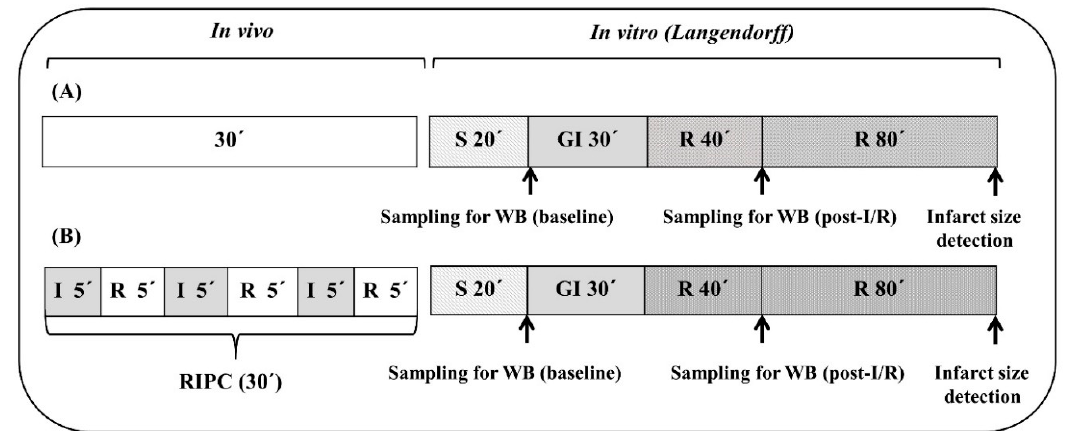
Figure 7. Schematic representation of the experimental protocols. ( A )—protocol of ischemia and reperfusion, ( B )—protocol of remote ischemic preconditioning, I—ischemia, R—reperfusion, RIPC—remote ischemic preconditioning, S—stabilization, GI—global ischemia, WB—Western blot analyses.